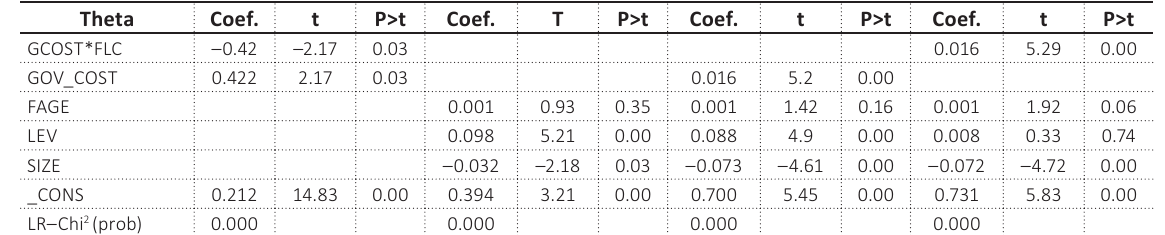
Table 7. Tobit results for aggregate datasets